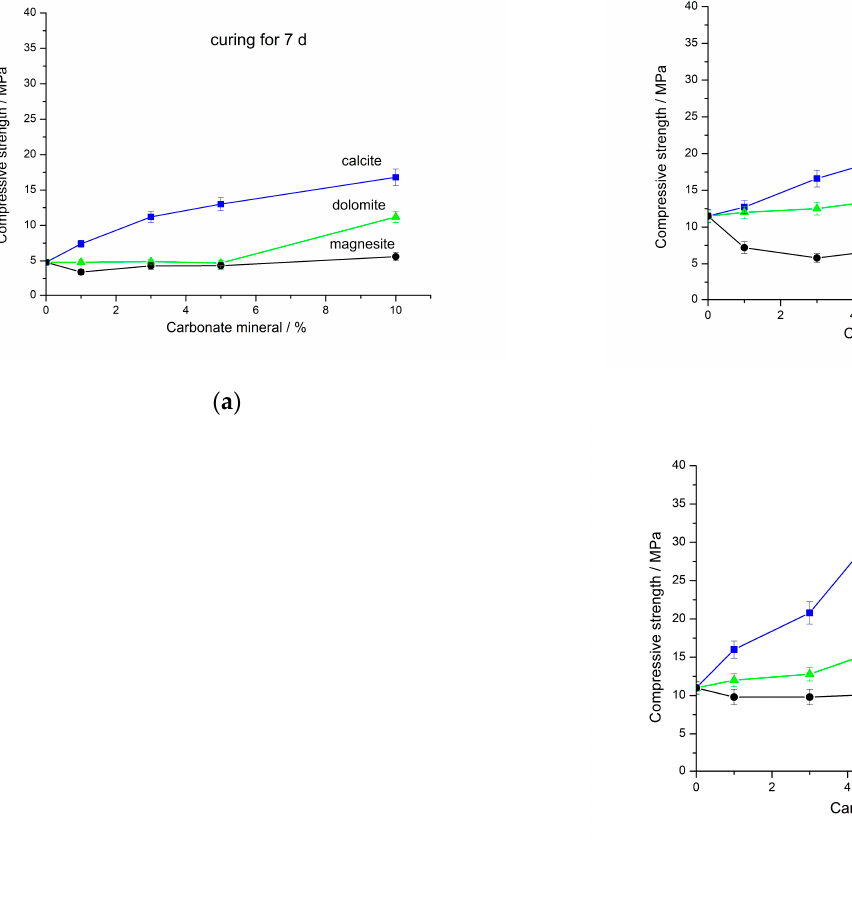
Figure 7. Effect of calcite, dolomite, and magnesite content on the compressive strength of geopolymers based on (FA + carbonate mineral) blends mechanically activated for 180 s and cured for: ( a ) 7 d; ( b ) 28 d; ( c ) 180 d. Data for calcite and dolomite are taken from [34] and [35], respectively.